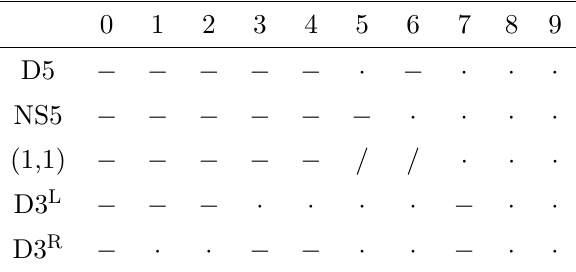
Table 1 . Directions along which a brane extends are denoted by a bar (–), while · denotes the directions along which a brane takes some fixed values. Finally, / implies that a (1,1)-brane extends along a line with a – 1 slope within the 56 plane.